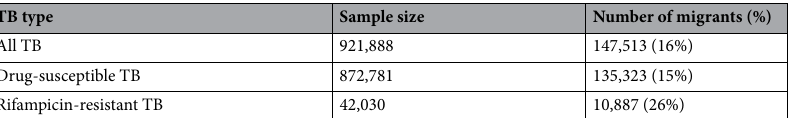
Table 1. Cross-municipality migration rate among people with laboratory-diagnosed TB stratified by TB type. We calculated migration rate as the percentage of migrants among people with at least two clinic visits in each group. We defined migrants as people with laboratory-diagnosed tuberculosis who submitted tuberculosis test samples to clinics located in more than one municipality. Data are laboratory tuberculosis test results, which were linked to identify individuals, from South Africa’s National Health Laboratory Service database. Patients test results were grouped into drug-susceptible and drug-resistant tuberculosis care episodes. People with no drug-resistant tuberculosis care episode were classified as drug-susceptible tuberculosis patients and people with at least one rifampicin-resistant tuberculosis care episode were classified as rifampicin-resistant tuberculosis